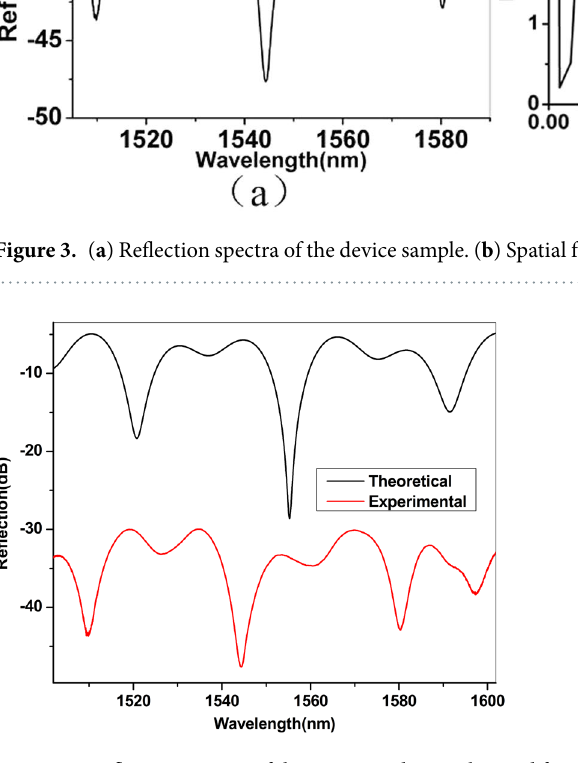
Figure 4. Reflection spectra of the FP cavity device obtained from theoretical simulations and